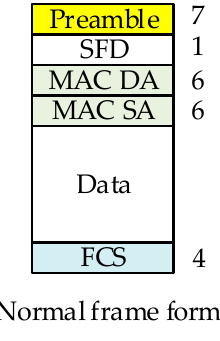
Figure 3. Receiver side MAC merge sublayer structure. Figure 3 . Receiver side MAC merge sublayer structure.